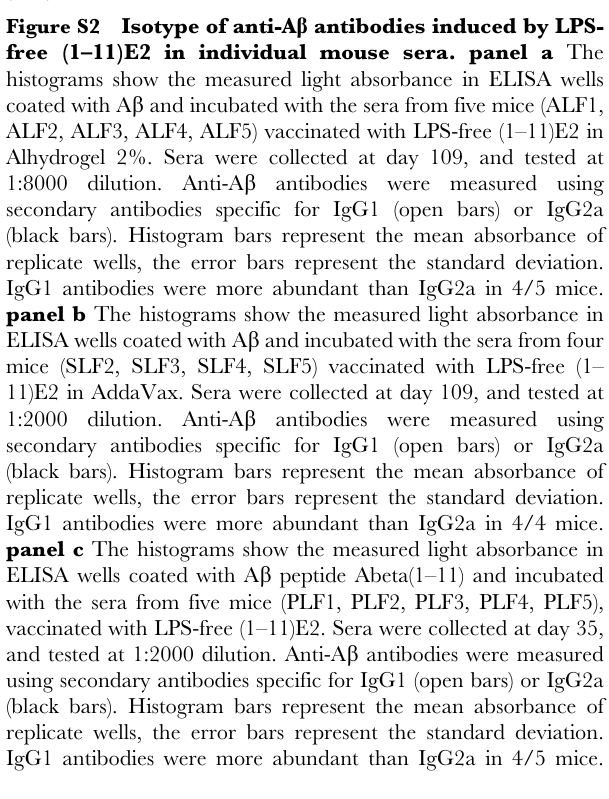
Figure S3 Persistence of the anti-beta amyloid titer in individual mice. The plot reports the anti-A b antibody titer at day 109 of B6C3/F1 mice immunized (day 0 and day 21) with LPS-free (1–11)E2, formulated in Alhydrogel 2% (diamonds), AddaVax (circles), or without adjuvant (triangles). Each symbol represents a mouse. In the adjuvanted groups, the anti-A b titer persisted above 1:15000 in all individuals, wheras in 2/5 mice receiving the unadjuvanted vaccine the day 109 titer is below 1:1000. (TIF) Figure S4 Recognition of distinct A b species by sera from mice immunized with differently adjuvanted formulations of the LPS-free (1–11)E2 antigen. Immuno- dot blot analysis conducted on 60 ng each of the indicated A b 42 species ( M , monomers; O , oligomers; P , protofibrils; F , fibrils) with 1:140,000 (Alhydrogel 2%), 1:80,000 (Addavax) and 1:5000 (PBS) dilutions of pooled (day 77) sera from B6C3/F1 mice.